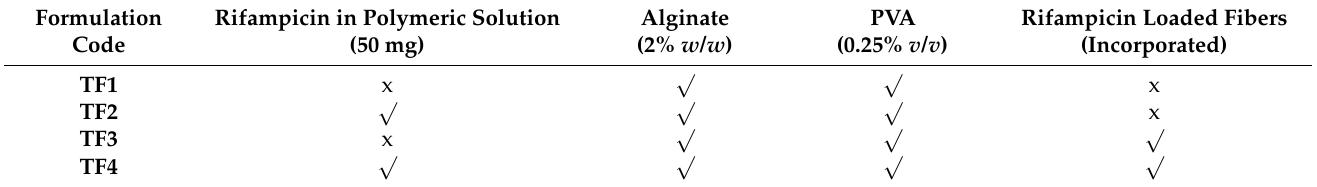
Table 2. Composition table of rifampicin fibers loaded transdermal